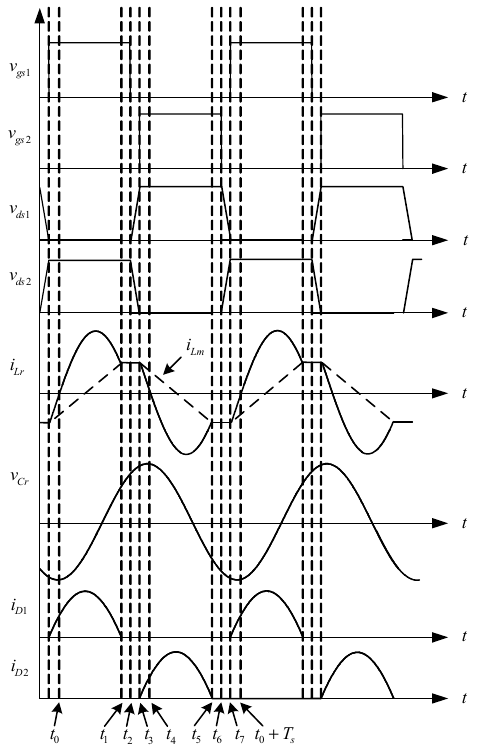
Figure 3. Key waveforms of the proposed LED driver over one switching